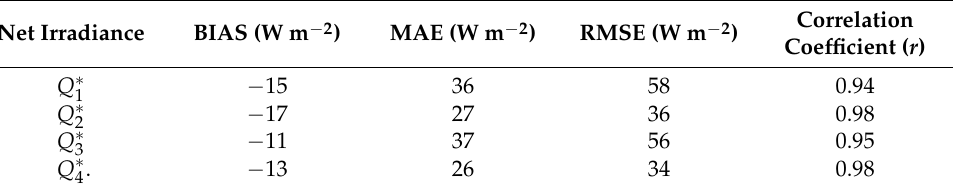
Table 17. Statistical errors and coefficients of correlation for Q ∗ Observatory Debrecen for the 10-year time period from 2008 to 2017.